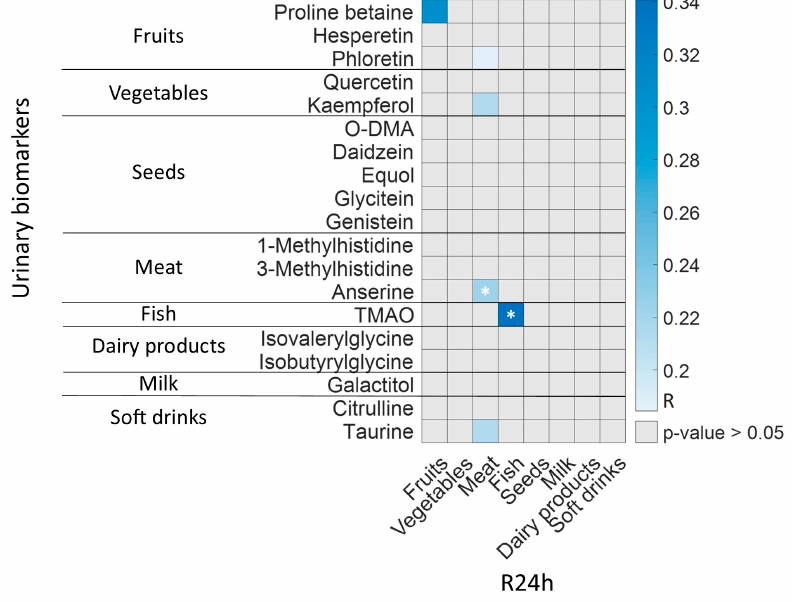
Figure 6. Significant correlations among BFIs and R24h food groups (Spearman’s correlation, Figure 6. Signi fi cant correlations among BFIs and R24h food groups (Spearman’s correlation, p - value < 0.05). Note: (*) p -value < 0.001. p -value < 0.05). Note: (*) p -value <